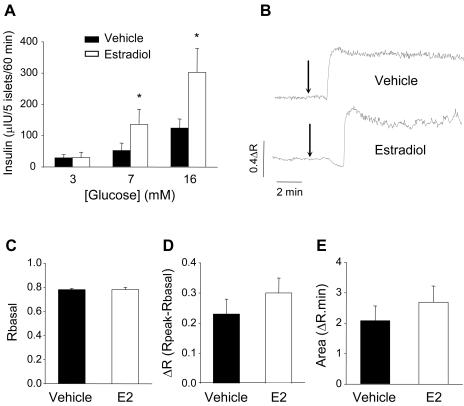
E2 action on insulin secretion and glucose-induced [Ca2+]i signals.(A) Glucose-induced insulin secretion from islets exposed to vehicle (black column) or 1 nM E2 (white column) for 48 hours with 3, 7 and 16mM glucose. (n = 3, 5 mice), * p<0.05 Mann-Whitney test compared to vehicle. (B) Record of fluorescence vs. time from whole islets of Langerhans treated with either vehicle or E2 in the same conditions described for experiments in figures 1–
3. The Ca2+-dependent fluorescence of Fura-2 is expressed as the ratio F340/F380 (Materials and Methods). Stimuli were applied when indicated by arrows. (C) Comparison of the fluorescence levels in the absence of stimuli between vehicle and E2-treated islets. (D) Increment of fluorescence between the fluorescence levels at the peak obtained with high glucose (Rpeak) and the basal fluorescence (Rbasal). (E) Area under the traces during 10 minutes beginning when R increases in response to glucose. At least 8 islets were used from 3 different mice. Note that no significant differences were found.